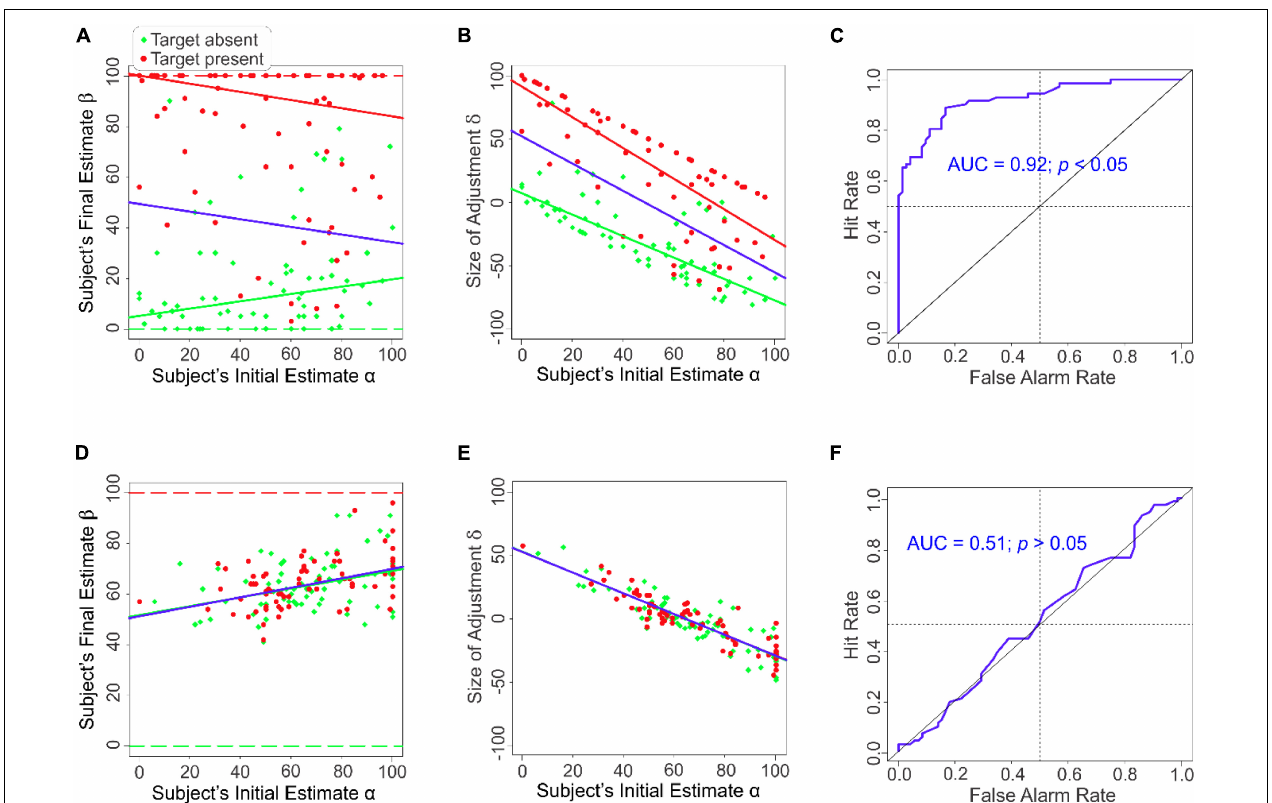
FIGURE 2 | Task performance with or without anchoring information in Experiment 1. Panels (A–C) results when the external anchoring information was not provided ( i.e. , Conditions 3 and 4). Panels (D,E) results when the external anchoring information was provided ( i.e ., Conditions 1 and 2). (A) Subjects’ final estimates as a function of their initial estimates in the absence of anchoring information. (B) The magnitude of the subjects’ adjustment δ as a function of their initial estimate α in the absence of anchoring information. (C) ROC analysis of the subjects’ final estimates in the absence of anchoring information. (D) The subjects’ final estimates as a function of their initial estimates in the presence of anchoring information. (E) The magnitude of the subjects’ adjustment δ as a function of their initial estimate α the presence of anchoring information. (F) ROC analysis of the subjects’ final estimates in the presence of anchoring information. Regression lines that best account for the data are shown in a color-coded fashion in panels (A,B,D,E) ( red , target present; green , target absent; blue , all data points). Note that in panels d and e, the blue line largely overlaps, and therefore obscures, the red and the green lines. The dashed lines in panels (A,D) denote the expected responses ( red , target present; green , target absent). TABLE 2A | Contribution of the various explanatory variables to the size of adjustment d when anchoring information was unavailable in Experiment 1 (Conditions 3 and 4).